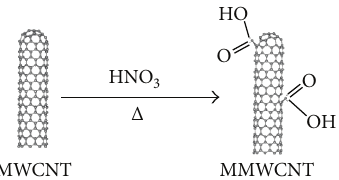
Figure 1: Chemical modification of carbon nanotubes through thermal oxidation